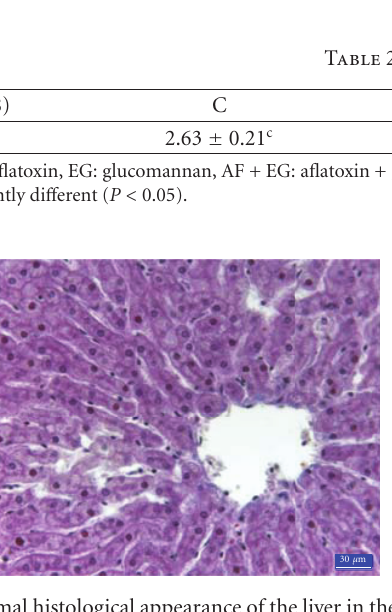
Figure 3: Mononuclear cell infiltration in portal areas in the AF + EG group (arrows), trichrome